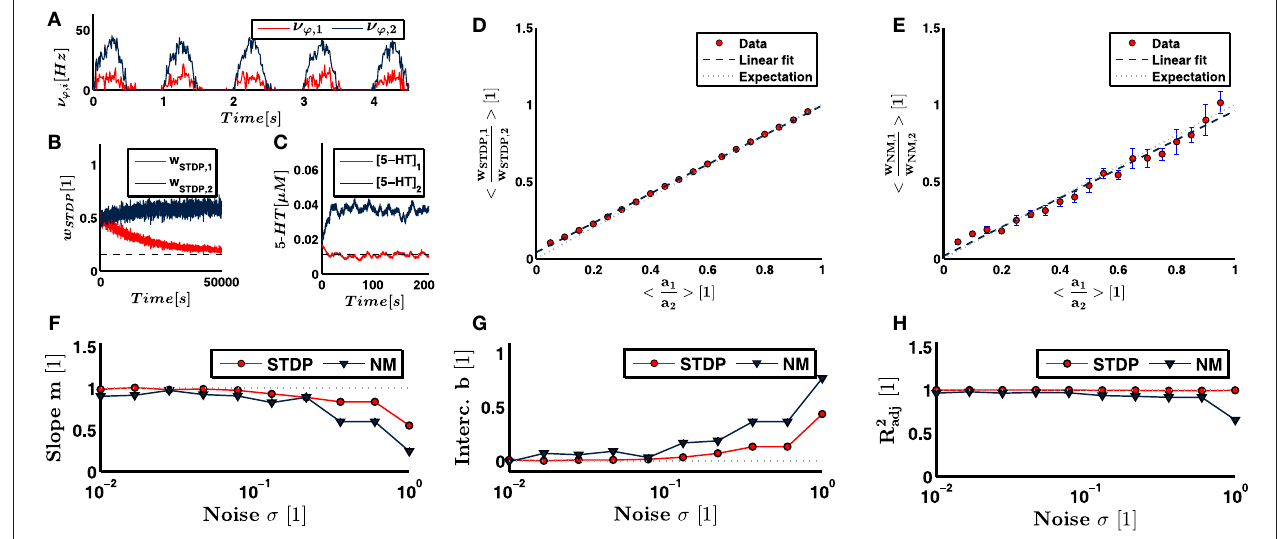
FIGURE 3 | Illustrated here are the results of the feed-forward neural network. (A) The firing rate of the sensory input neurons from joint 1 and 2 for one example run with an underlying eigenmode described by the ratio a 1 / a 2 = 0.3 . Both input and output weights are supposed to align with the dominant principal component, i.e., eigenmode. (B) The evolution of the synaptic input weights under the influence of STDP for the two neuron pools. The expected ratio w STDP , 1 / w STDP , 2 = 0.3 and the converged synaptic strength corresponding to joint 2, w STDP , 2 , determine the expectation value for w STDP , 1 . The expectation value is indicated as dashed line. (C) Same illustration for the serotonin concentration, which corresponds to output weighting. (D) The ratio of plastic input weights linearly increases with the expected ratio, i.e., a 1 / a 2 . (E) demonstrates the same behavior for the neuromodulatory output weights. Theoretically predicted is a line of unit slope and zero y-intercept. (F,G) When the noise in the sensory input increases, the slope and intercept of the linear fit increasingly deviate from the expectation. (H) Even for large noise levels, we find an adjusted R 2 value close to 1 . This indicates that our linear fits, and hence the obtained values for the slope and y-intercept, remain